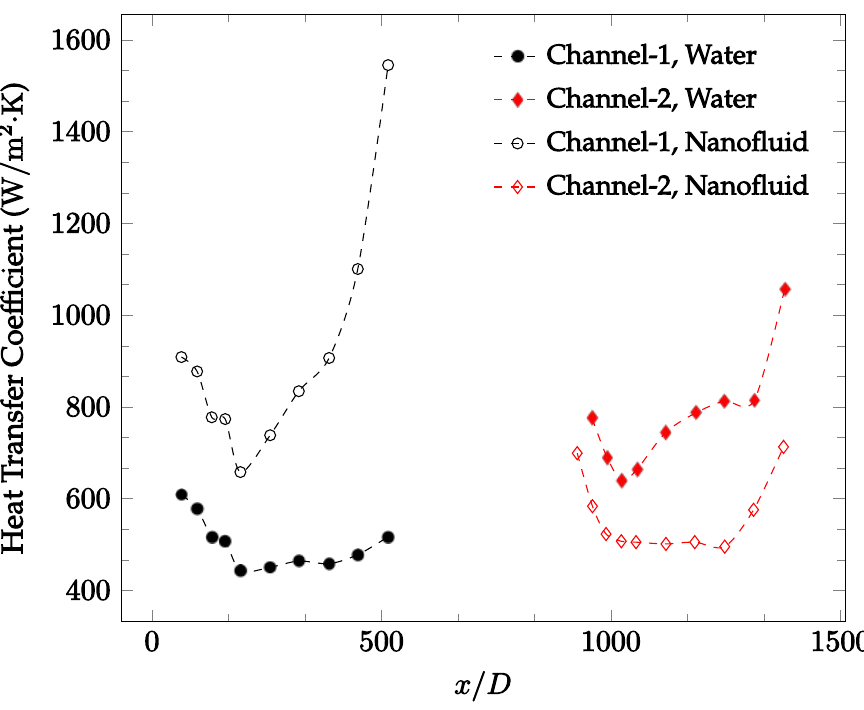
Figure 20. Change in convective heat transfer coefficient of deionized water and Fe 3 O 4 -deionized water nanofluids as a function of dimensionless distance for a Reynolds number of 20-25. The nanoparticle concentration was 1% by weight. A converging nozzle is used as a connector.